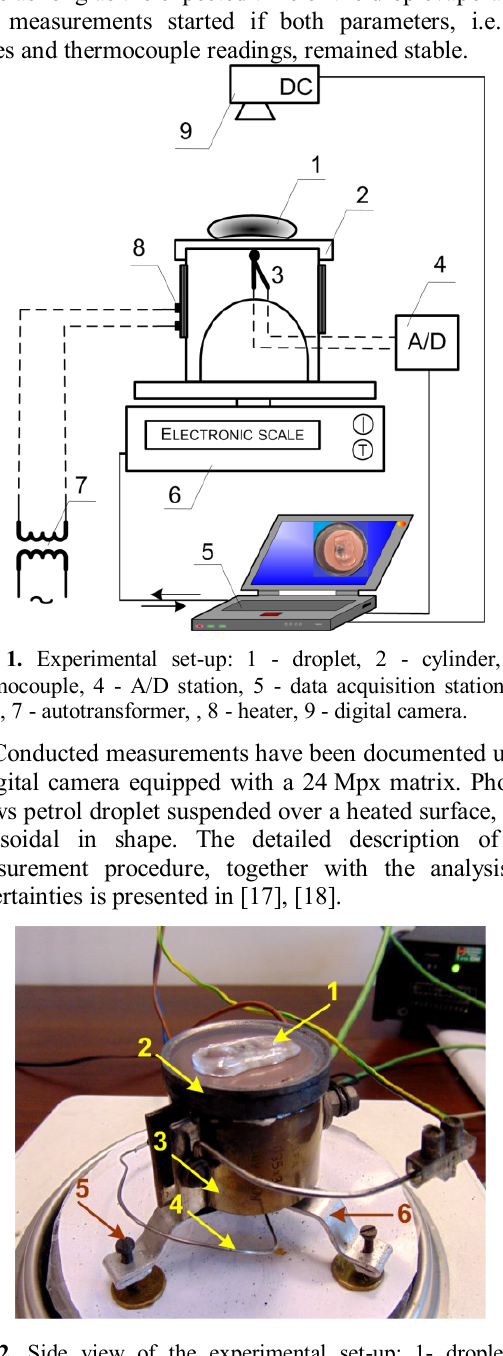
Fig. 2. Side view of the experimental set-up: 1- droplet, 2- cylinder, 3- heater, 4- thermocouple, 5- screw, 6- supporting